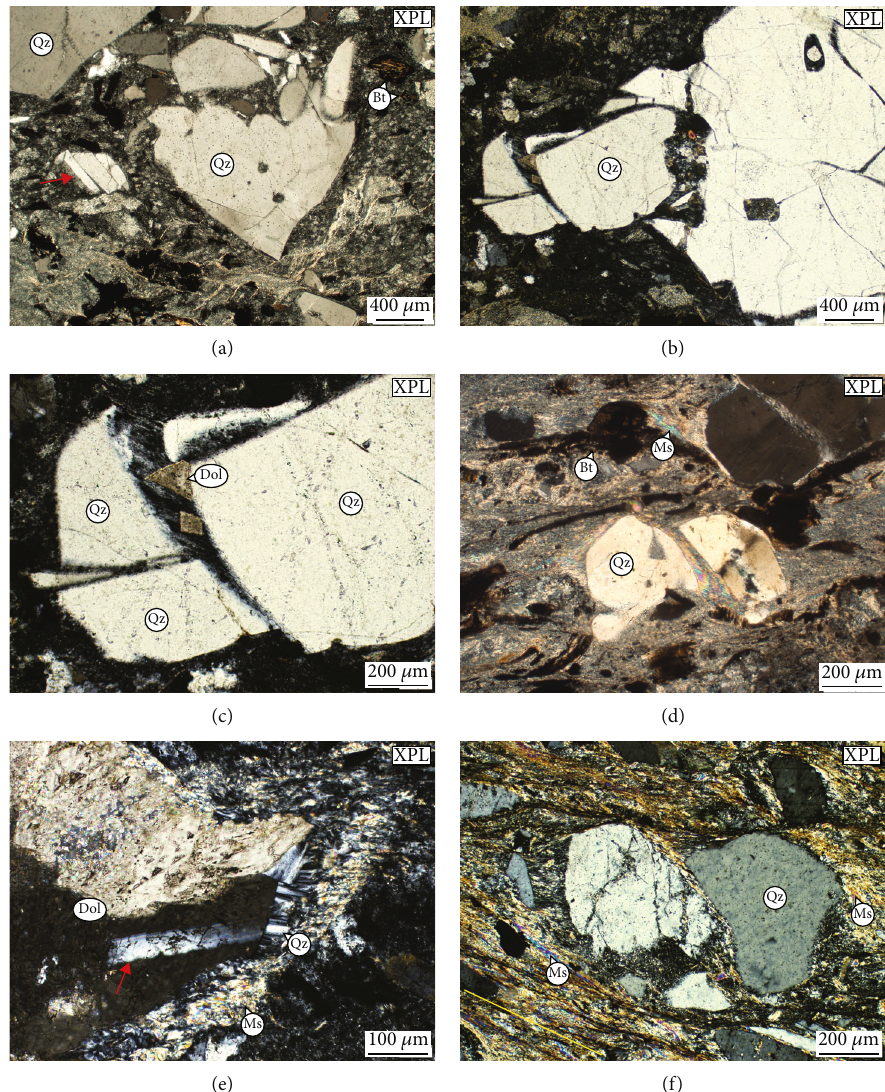
Figure 8: Thin-section photomicrographs of the Permian ignimbrites: deformation textures ((a – c, e) well Kel – 7 core #8; (d) well Kel – 7 core #7; (f) well Kel – 23 core #3). (a) Domino-type fragmented quartz porphyroclast (red arrow). (b, c) Mosaic fragmented quartz porphyroclast. Note: fragmentation is postdated by dolomite crystallization in the matrix. (d) White mica strain shadows around fragmented quartz porphyroclasts in a fi ner grained matrix (the section is normal to the foliation). (e) Elongated quartz strain shadow around a dolomite replacing an earlier feldspar phenocryst. Note: mechanical twinning in dolomite (red arrow). (f) Disjunctive foliation in a deformed ignimbrite sample (the trend of the cleavage domains is indicated by the yellow line; the section is normal to the foliation). Note: strain shadows are associated with strain caps. Abbreviations: XPL: cross-polarized light; Bt: biotite; Dol: dolomite; Ms: muscovite; Qz: quartz; Zrn: